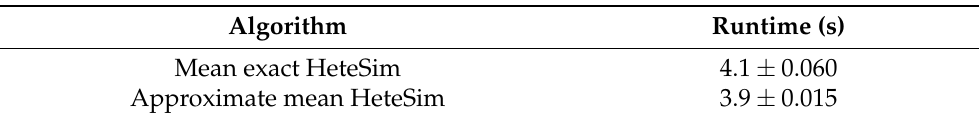
Table 3. For approximate mean HeteSim, the realistic parameters (cid:101) = 0.1 and r = 0.9 were used. The third algorithm variant, approximate mean pruned HeteSim, was not run on the actual knowledge graph, due to excessive runtime when using realistic values for (cid:101) and r . Table 3. Mean and standard deviation of runtimes for the mean exact HeteSim and approximate mean HeteSim